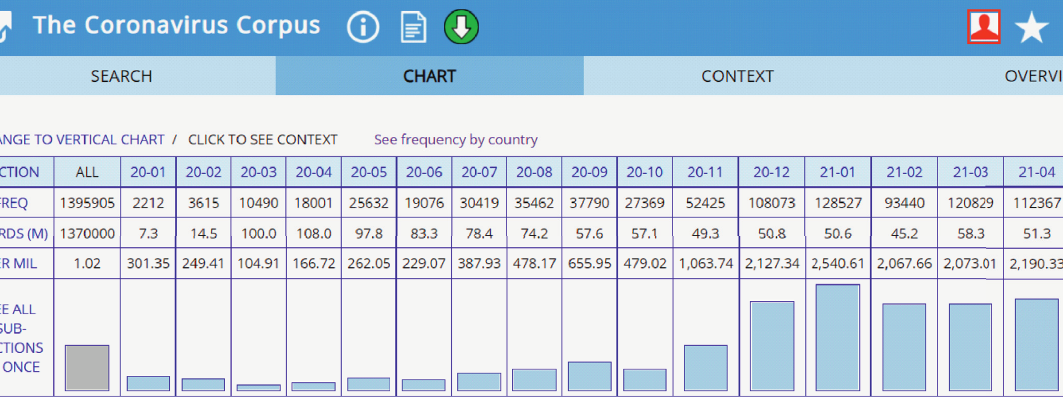
Figure 2: The frequencies of “VACCINE” in The Coronavirus Corpus [31].